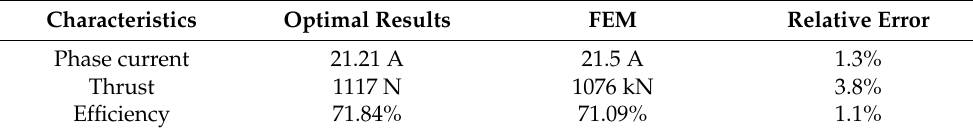
Figure 8. The time curve of thrust acting in the xdirection and y-direction of the mover. Table 5. Some of the key characteristics of analytical calculation and 2-D transient FEM.